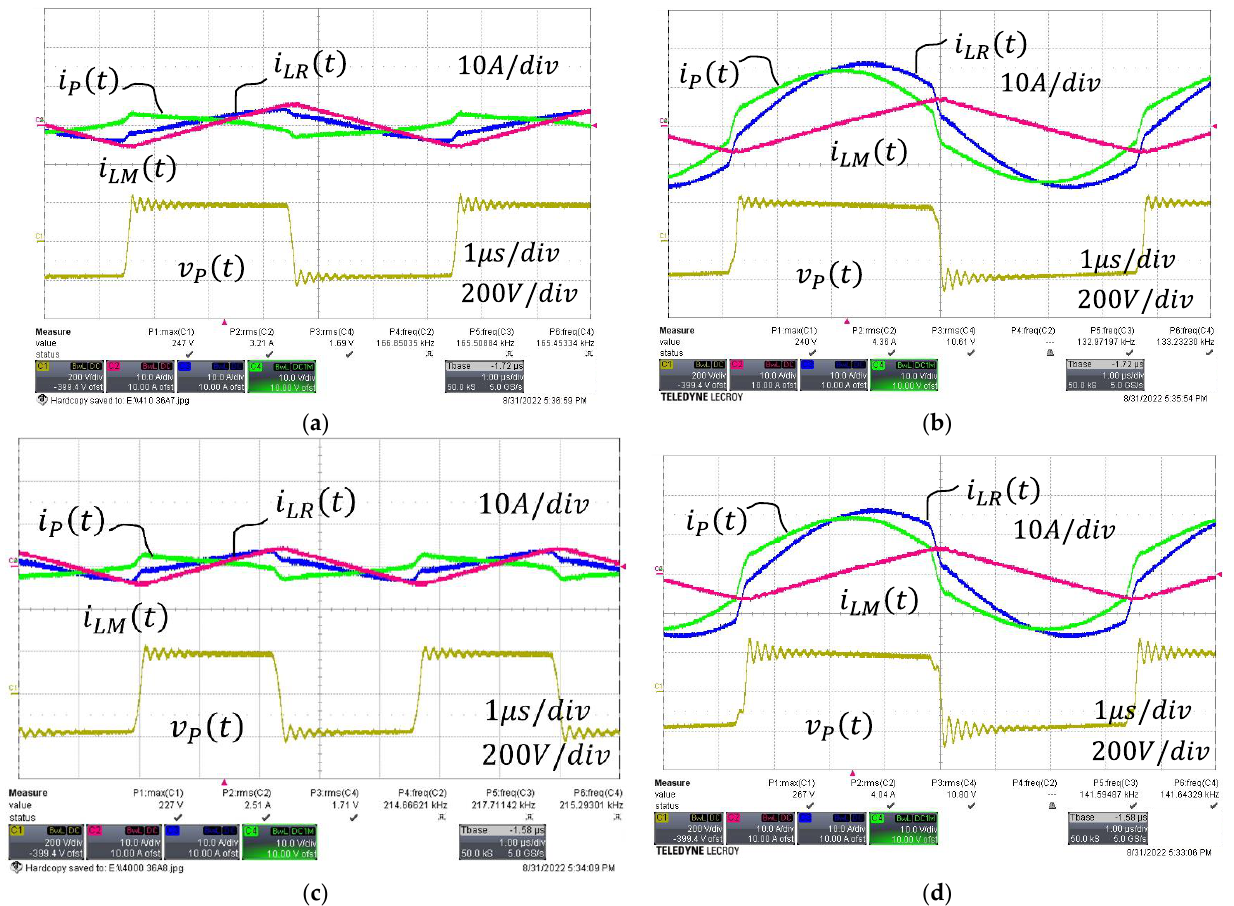
Figure 18. Experimental waveform in steady-state: ( a ) At an input voltage of 390 V and load current of 4 A; ( b ) at an input voltage of 390 V and load current of 36 A; ( c ) at an input voltage of 400 V and load current of 4 A; and ( d ) at an input voltage of 400 V and load current of 36 A. Table 4. Main components and electrical ratings used in the experimental circuit.